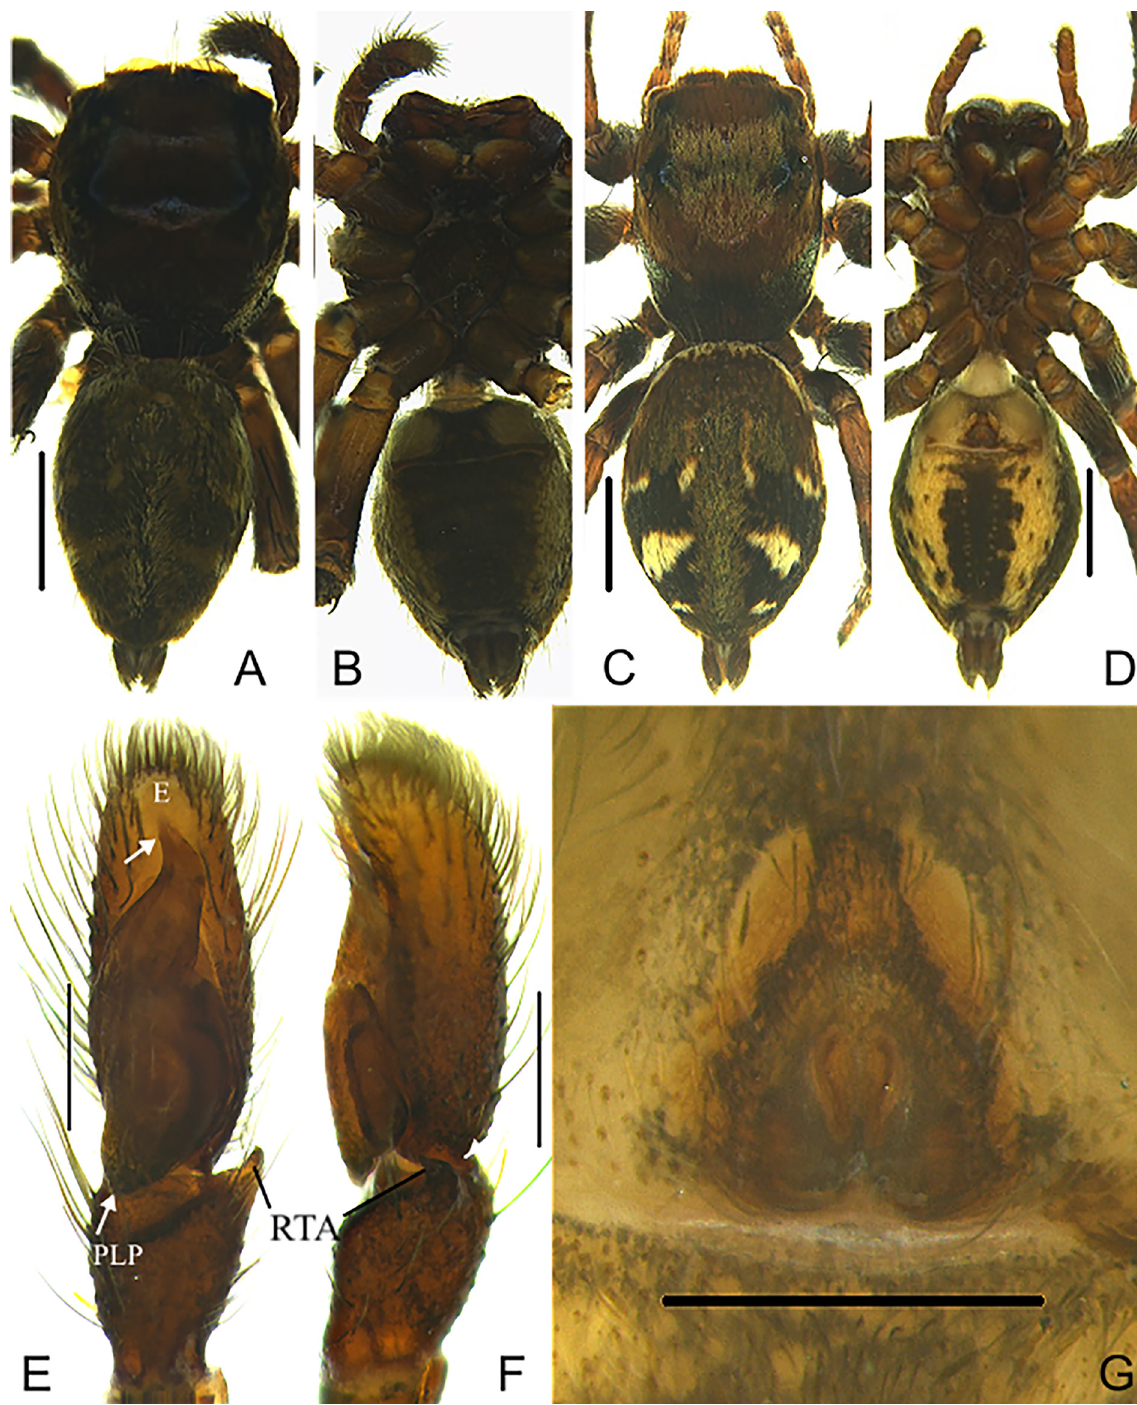
Fig 6. Carrhotus atratus sp. nov. A–B . Male habitus. A . Dorsal view. B . Ventral view. C–D . Female habitus. C . Dorsal view. D . Ventral view. E–F . Palp. E . Ventral view. F . Retrolateral view. G . Epigynum. Abbreviations: E = embolus; PLP = posterior lateral protrusion; RTA = retrolateral tibial apophysis. Scale bars: A–D = 2 mm; E–F = 0.2 mm; G = 0.1